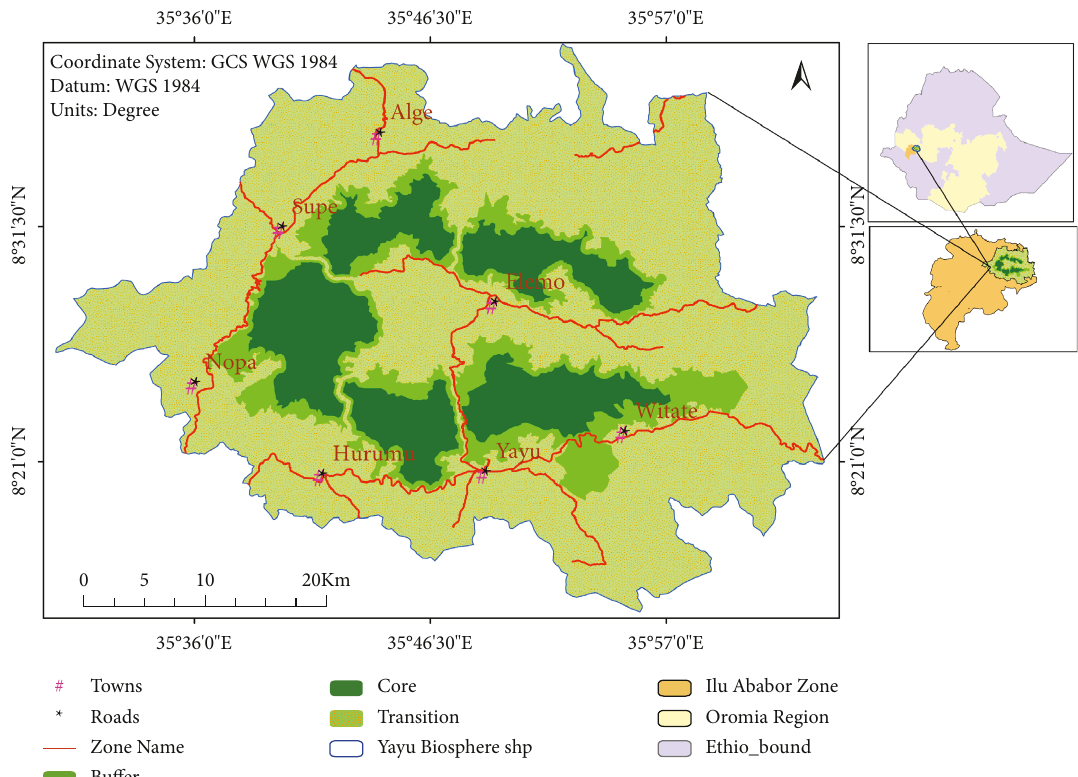
Figure 1: Map of the study